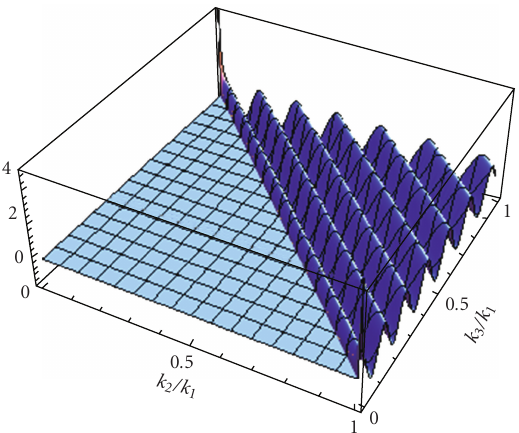
Figure 8: The running and shape of the resonance bispectrum (150) with C = 100.